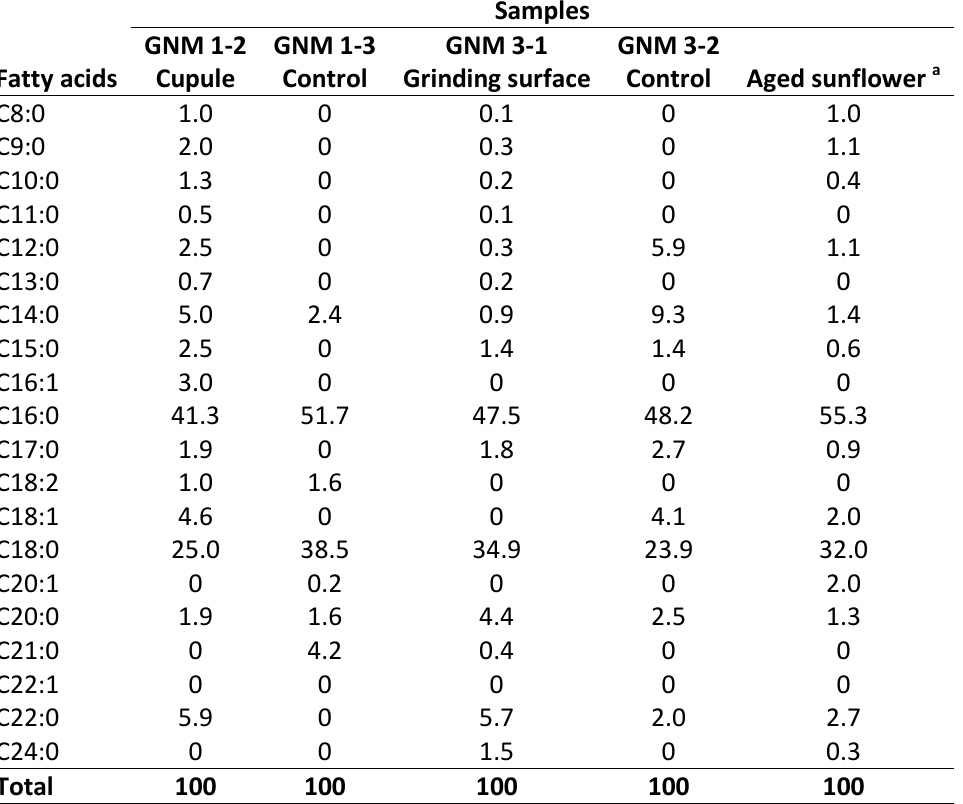
Table 3. Relative percentages of fatty acids in Gila Cliff Dwellings samples and in an aged sunflower seed residue.